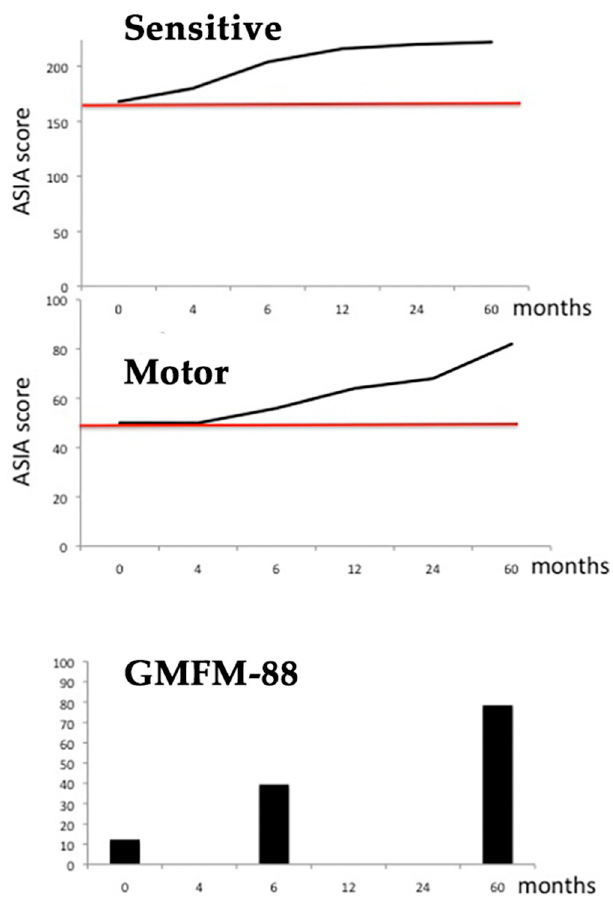
Figure 1. Graphic representation of the results obtained. Upper graph: Sensitive evolution (pin prick score + light touch score; left + right hemibodies) according to the ASIA (American Spinal Injury Association) scale. Maximal score (y axis): 224. The red line delimits the starting point (168), since no abnormalities existed above L3; Middle graph: Motor evolution according to the ASIA scale. Maximal score (y axis): 100. The red line delimits the starting point (50), since no abnormalities existed above L3; Lower graph: Evolution of the Gross Motor Function Test (GMFM)-88 test. Note that the intervals in the x-axis only indicate the age (in months) at which the scores were registered in each graph once the treatment commenced (month 0).